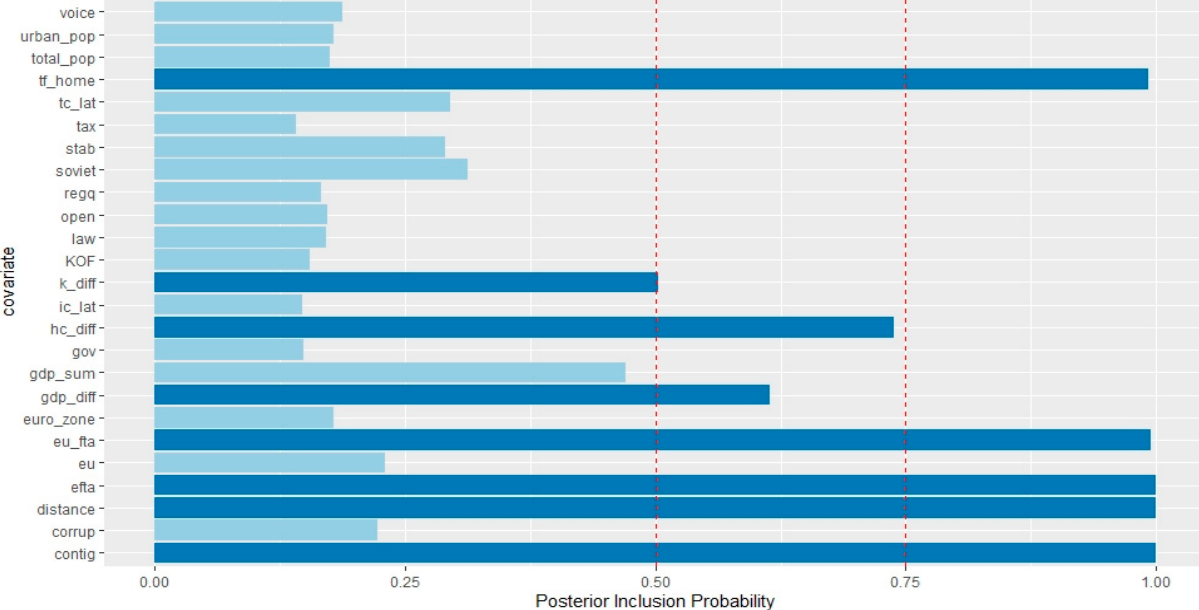
Figure 4. Inclusion probabilities for each of the potential covariates for Latvia, restricted case (2004–2017).